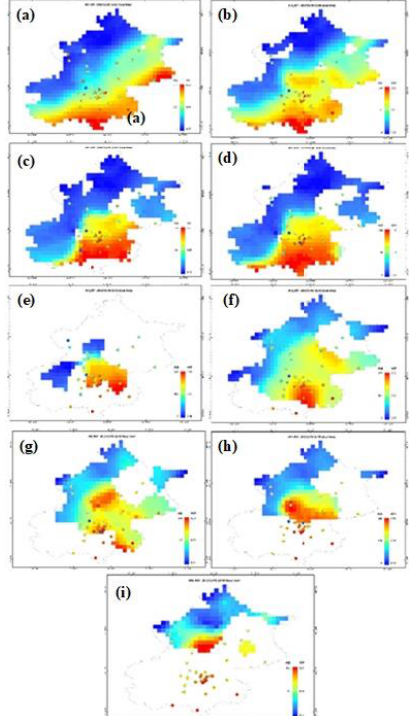
Figure 11. a case of spatial distribution of aerosol loading on 01 December 2018.